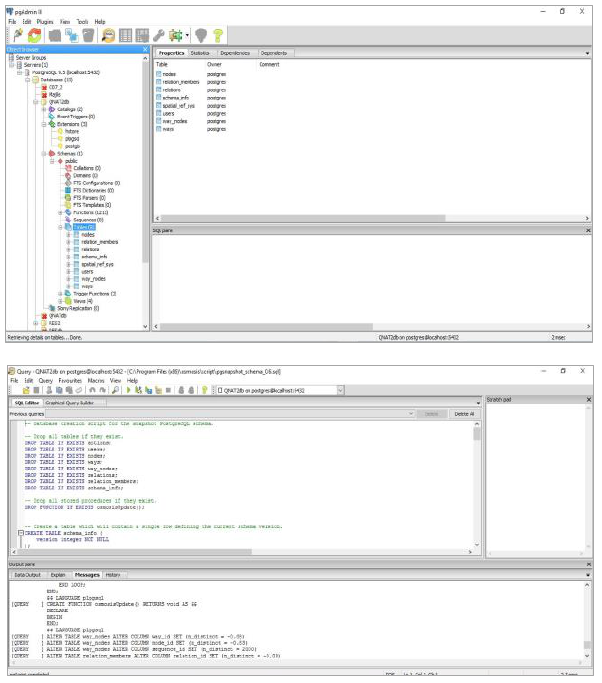
Figure 9. Development of databases and running SQL